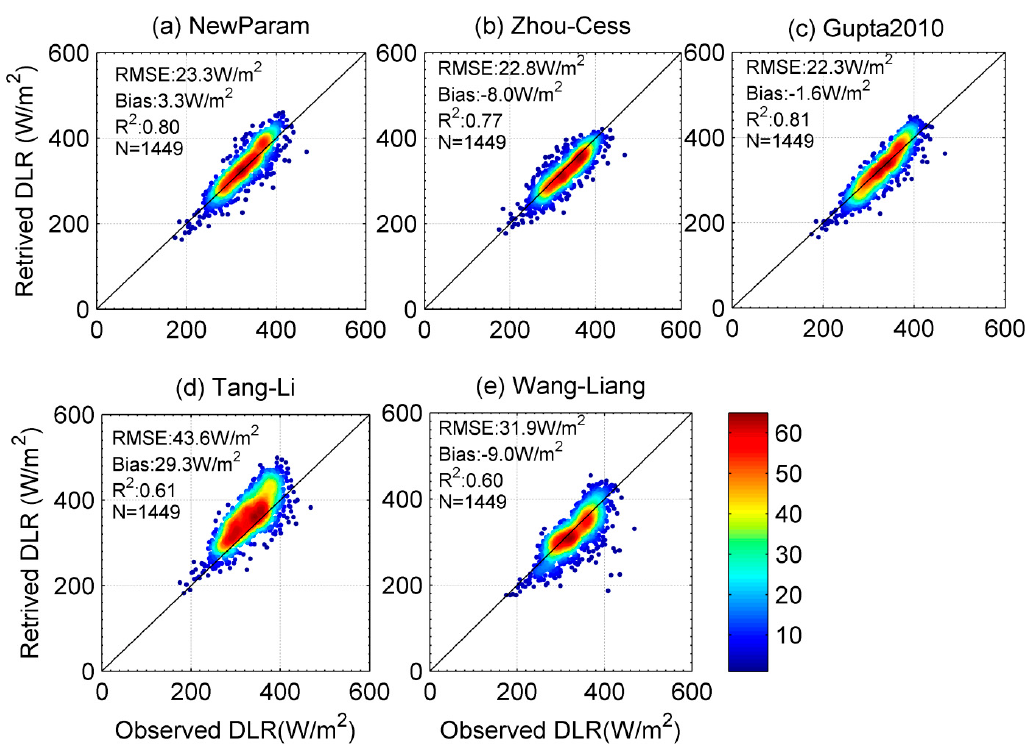
Figure 9. Comparison between MODIS-estimated DLRs and in-situ measurements at the sites in ordinary regions. Figures ( a ) to ( e ) represent the results from the new parameterization (NewParam), Tang-Li, Wang-Liang, Zhou-Cess, and Gupta2010 algorithms. The color bar represents data density that ranges from 0 to 100 percent of the data.